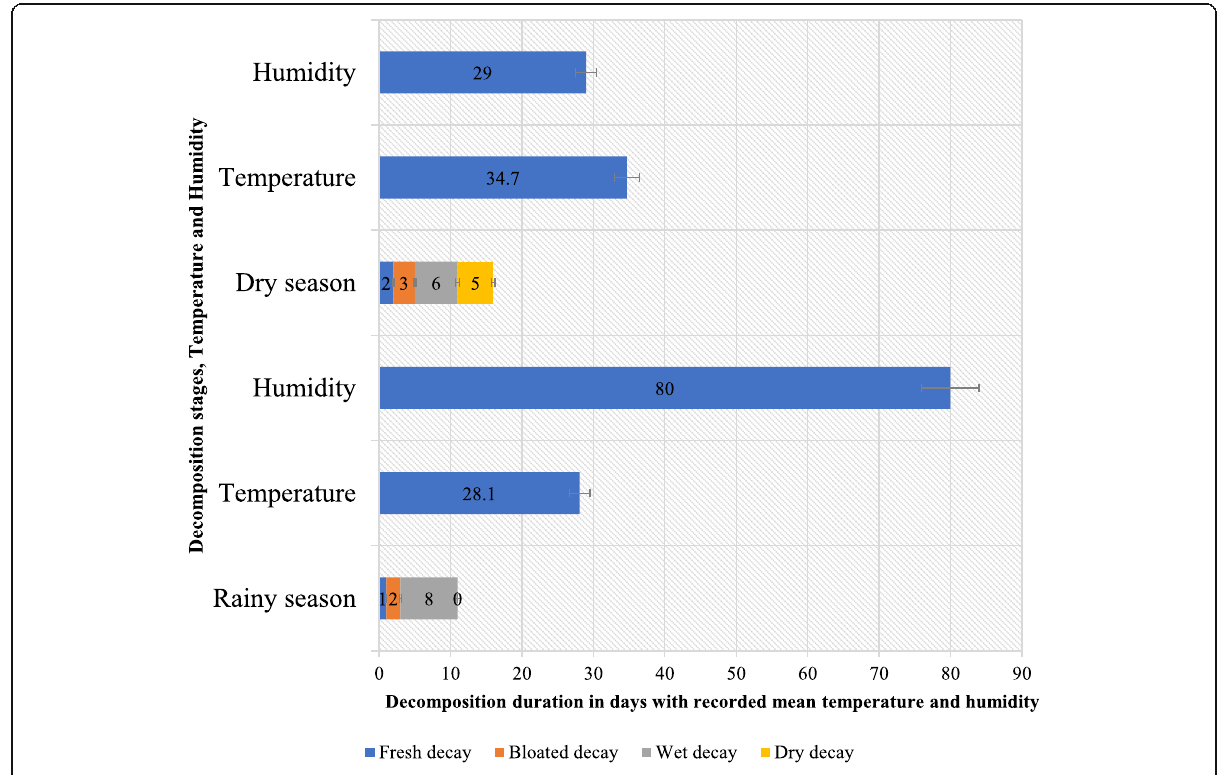
Fig. 4 Decomposition stages and their duration in days in the building during the rainy and dry seasons of Awka,